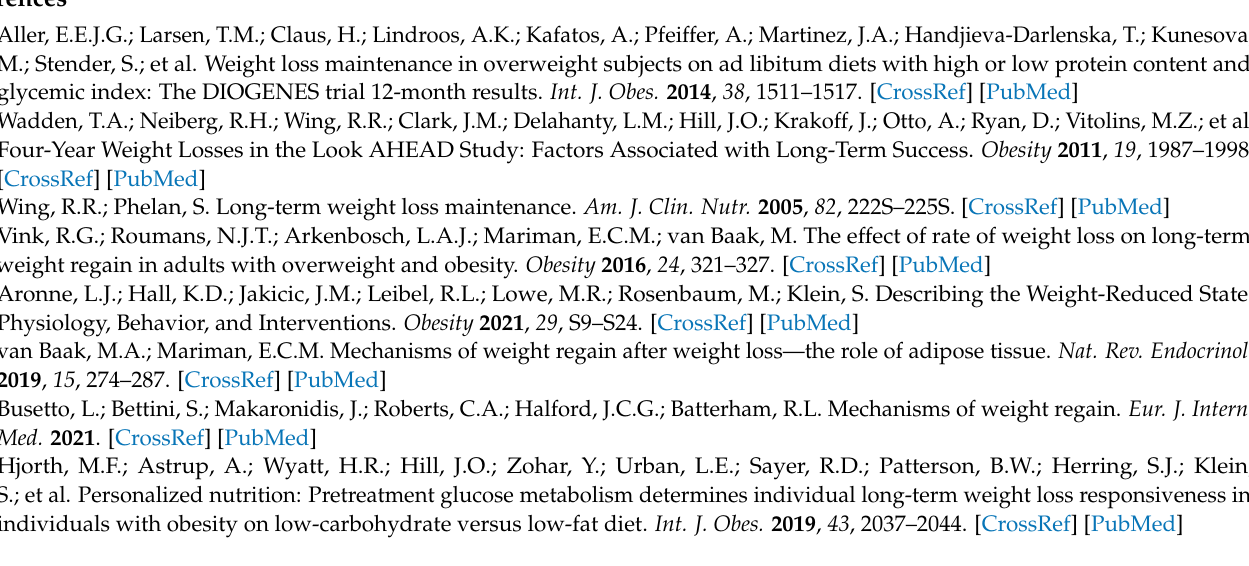
n = 39); red dots/line: FPG > 5.6 mmol/L (regression analysis B = − 0.123, SE 0.138, p = 0.397; n = 10), Supplemental Figure S7: Weight regain in groups of subjects with different combinations of baseline FPG and mono- and disaccharide intake. Group 1: baseline FPG < 5.6 mmol/L and mono- and disaccharide intake during the FU period ≤ median (20.0 energy%); group 2: FPG < 5.6 mmol/L and > median mono- and disaccharide intake; group 3: FPG ≥ 5.6 mmol/L and ≤ median mono- and dis- accharide intake; group 4: FPG ≥ 5.6 mmol/L and > median mono- and disaccharide intake ( n = 49), Figure S8: Association between the CHO to fibre intake ratio during the FU period and weight regain ( n = 53). Regression analysis: B = 0.261, SE 0.205, p = 0.208, Figure S9: Associations between CHO to fibre intake ratio during the FU period and weight regain in the participants with baseline normoglycemia ( ≤ 5.6 mmol/L) and those with baseline elevated FPG (>5.6 mmol/L). Blue dots/line: FPG ≤ 5.6 mmol/L (regression analysis: B = 0.332, SE 0.218, p = 0.137; n = 39); red dots/line: FPG > 5.6 mmol/L (regression analysis B = − 0.065, SE 1.094, p = 0.954; n = 10), Supplemental Figure S10: Weight regain in groups of subjects with different combinations of baseline FPG and mono- and disaccharide intake. Group 1: baseline FPG < 5.6 mmol/l and CHO-to-fibre intake ratio during the FU period ≤ median (8.92); group 2: FPG < 5.6 mmol/L and > median CHO-to-fibre intake ratio; group 3: FPG ≥ 5.6 mmol/L and ≤ median CHO-to-fibre intake ratio; group 4: FPG ≥ 5.6 mmol/L and > median CHO-to-fibre intake ratio ( n =